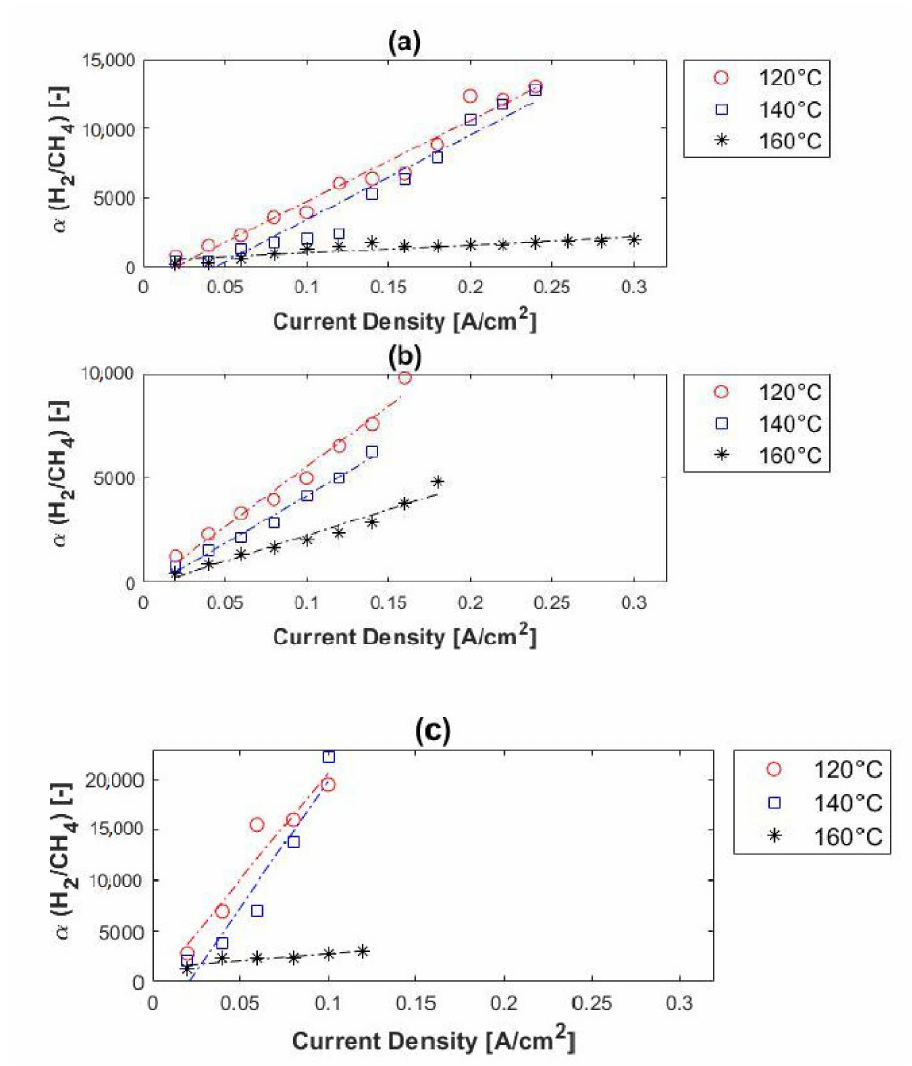
Figure 10. H 2 /CH 4 selectivity, in terms of methane concentration, versus current density: ( a ) 10% ( b ) 50% and ( c ) 80% methane, balance hydrogen (hydrogen flow rate = 100 mL n /min, 1